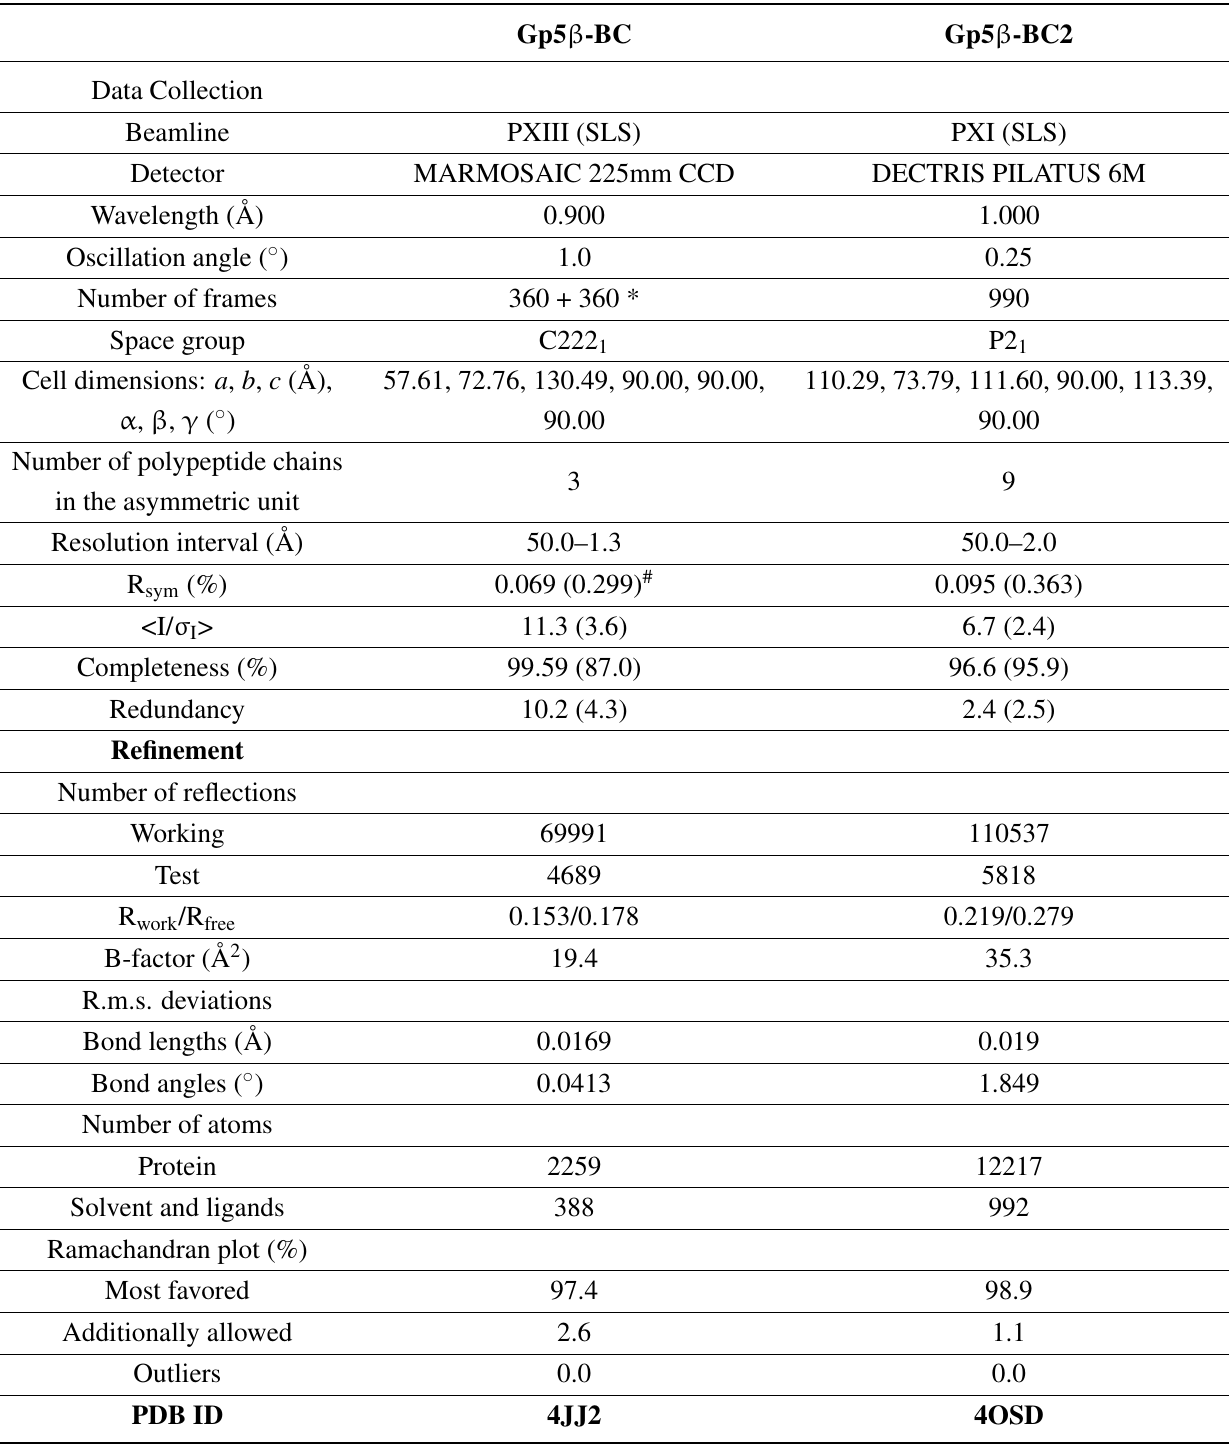
Table 1. Crystallographic